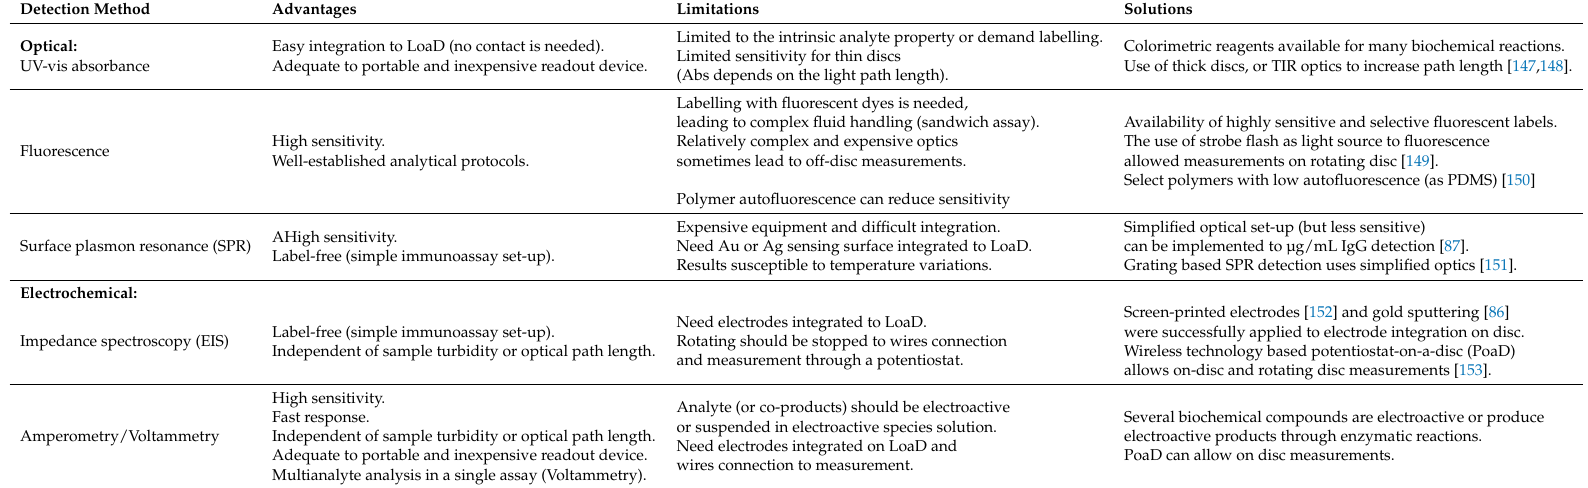
Table 2. Detection strategies in LoaD biosensors, advantages, limitations and